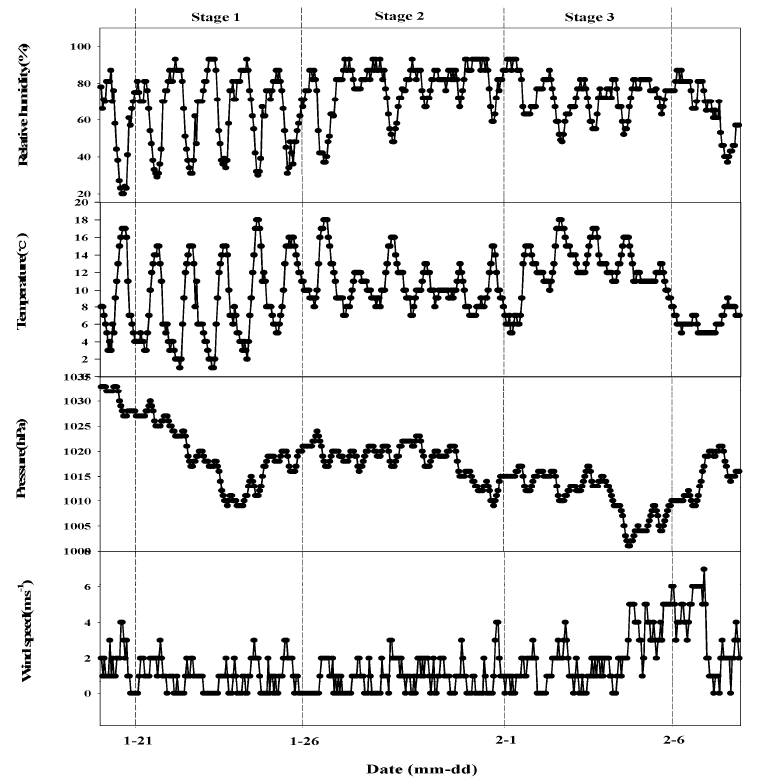
Figure 4. The temporal variation of the meteorological variables in Chengdu during the 2014 spring festival at a one-hour time interval.